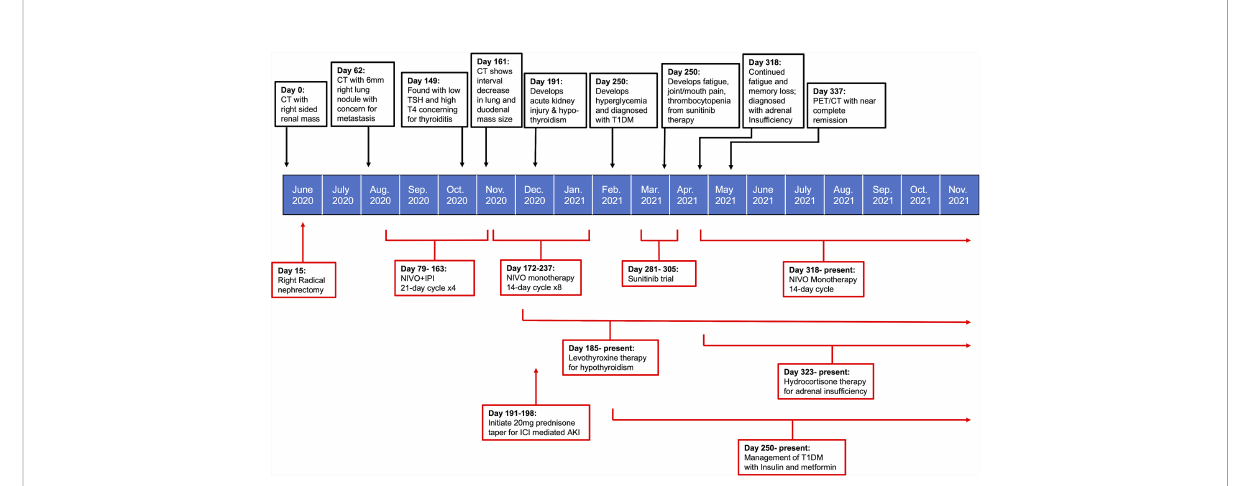
FIGURE 2 Timeline summarizing patient ’ s treatment course in relation to onset and management of